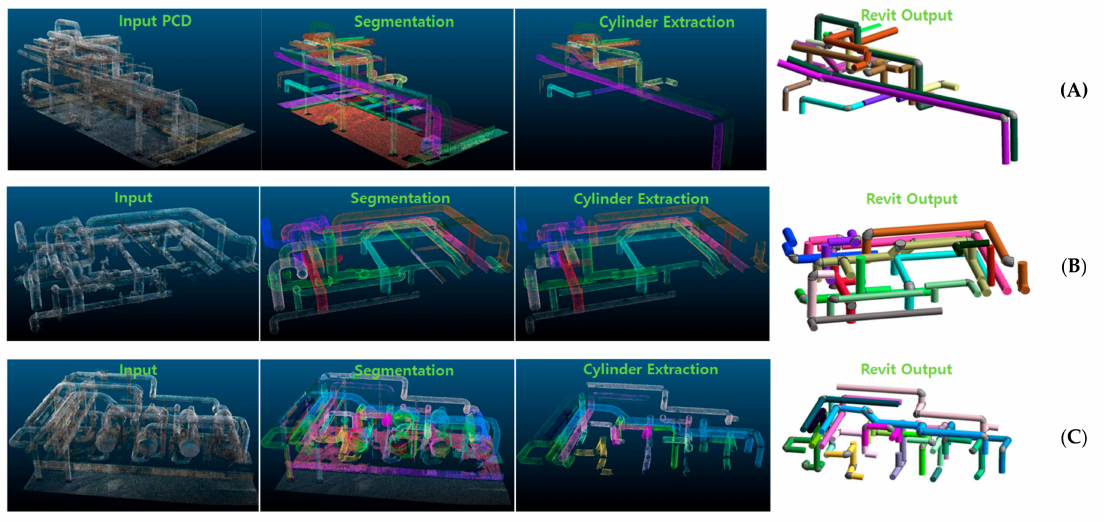
Figure 10. Scan-to-BIM Mapping Pipeline Results ( A , B , C